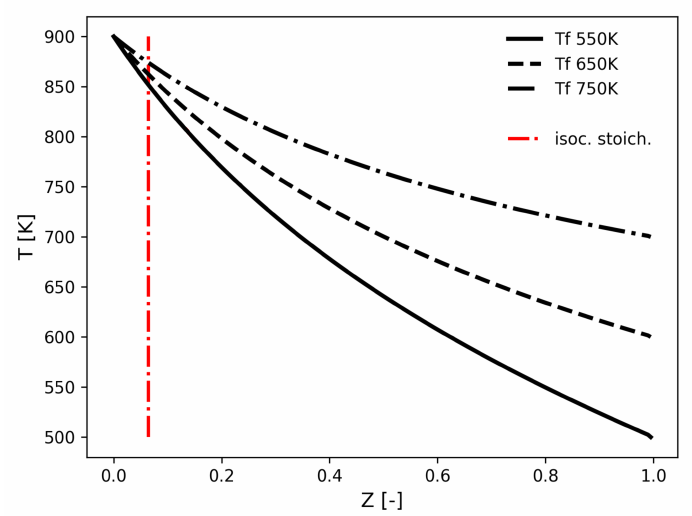
Figure 3. Evolution of the charge temperature with mixture fraction for different fuel temperatures